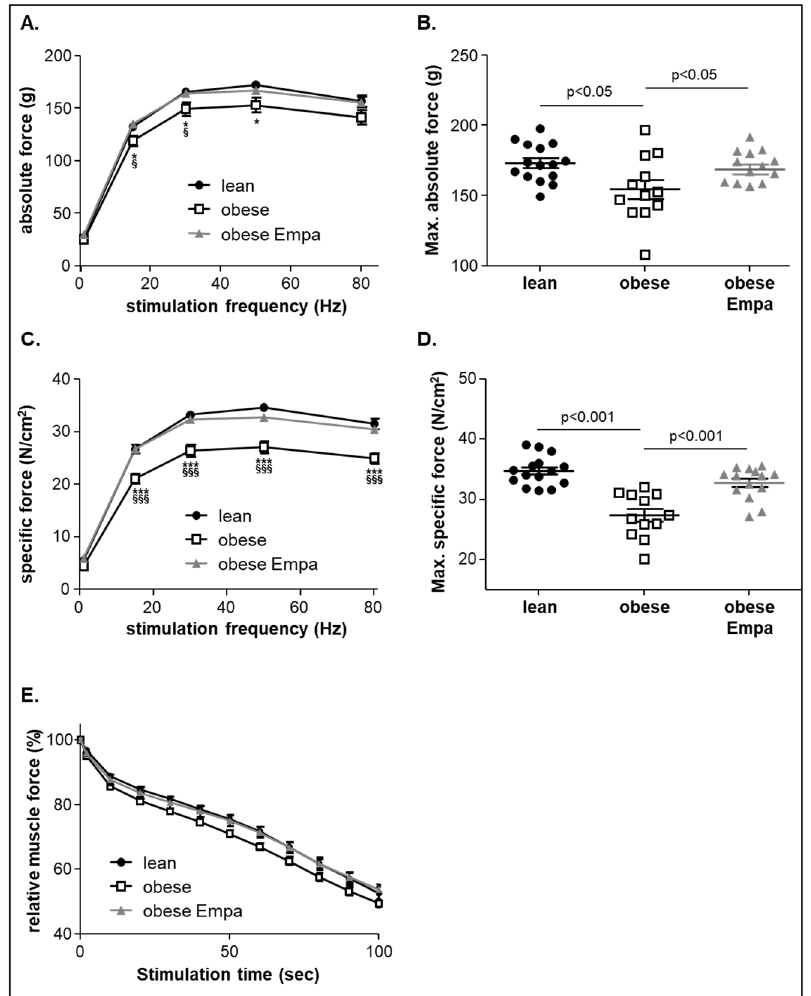
Figure 2. Absolute ( A ), maximal absolute force ( B ), specific ( C ) and maximal specific muscle force ( D ) was measured ex vivo from ZSF1-lean (lean, black circles), ZSF1-obese (obese, open squares) and ZSF1-obese rats treated with empagliflozin (obese + Empa, grey triangle) ( n = 12–15 per group). Furthermore, muscle fatigue of the soleus muscle was assessed by repetitive stimuli in all three groups and expressed as relative muscle force ( E ). Results are expressed as mean ± SEM. * p < 0.05, *** p < 0.001 vs. lean; § p < 0.05, §§§ p < 0.001 vs. obese + Empa.